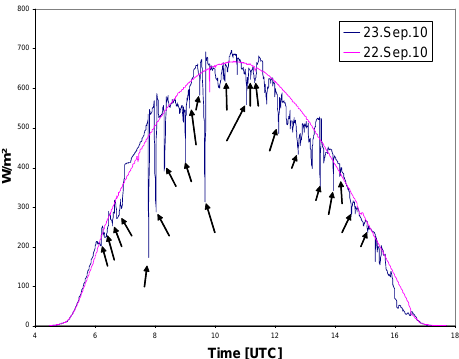
Figure 2. Global irradiance of two consecutive days: 22 and 23 September 2010. 22 September was a clear sky day without contrail persistence whereas on 23 September 2010 a strong con- trail persistence (altogether 49 persistent contrails from 06:00 to 16:00UTC) was observed. The arrows show the decrease in global irradiance due to contrails shading the sun (altogether 22 such events were observed). The clear sky day corresponds to the clear sky reference I cs . For simplicity purposes the model simulation which, perfectly agrees with the measurements is not shown (repro- duced with permission from Weihs et al., 2013; Copyright (2013), AIP Publishing